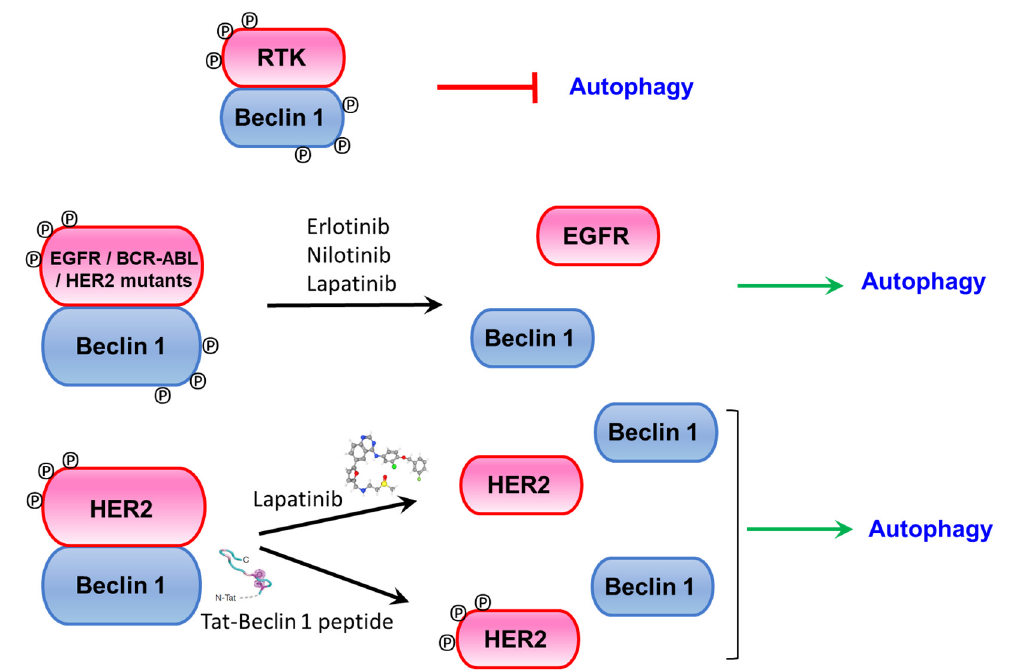
Figure 4. Models on RTK-Beclin 1 complex effects and autophagy induction upon receptor tyrosine kinase inhibitor or Tat-Beclin 1 autophagy-inducing peptide treatment.